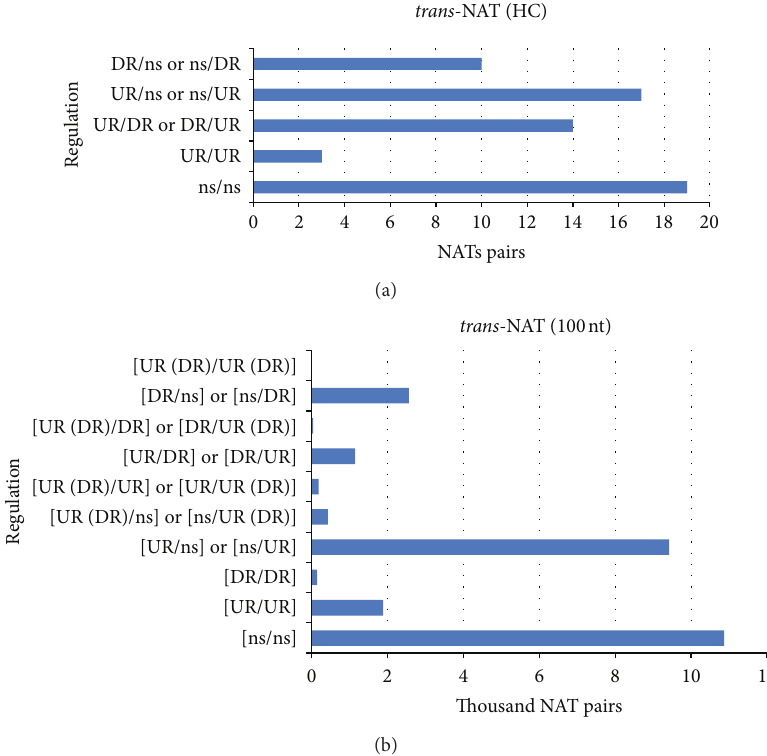
Figure2:Numbersof trans -NATpairsobservedintwoclasses(HC:“high-coverage”,complementaryregioncoveredmorethanhalfthelength of either transcript; “100nt”: pair of transcripts showing a continuous complementary region longer than 100 nucleotides; PlantsNATsDB database) showing pair regulation based on soybean unitags mapped in both sequences of each pair. The unitags were from library infected with Phakopsora pachyrhizi or not and expressed as UR (upregulated), DR (downregulated), or ns (no-significant at 𝑃 < 0.05